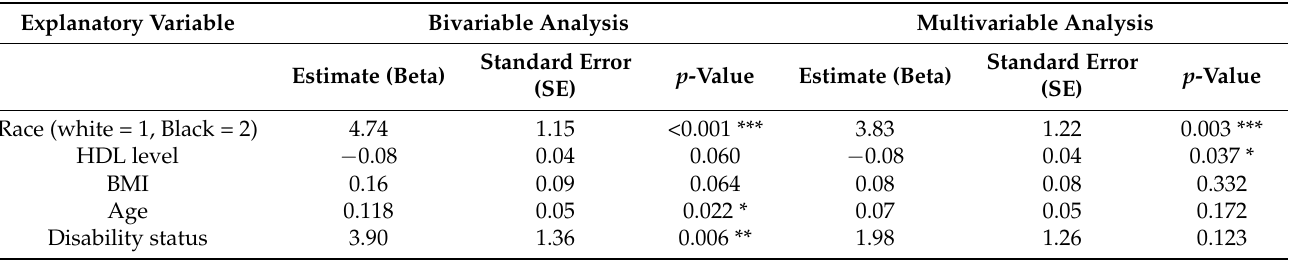
Table 2. Bivariable and multivariable linear regression analyses examining factors associated with HbA1c level ( n = 61).